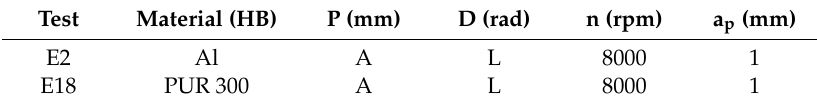
Figure 11. Predictive error graph for PUR 300. The values of the robotic machining variables and parameters that provide lower cutting tool path deviation outputs are shown in the following Table 6. Table 6. Machining variables and parameters for SEMPAD. Test